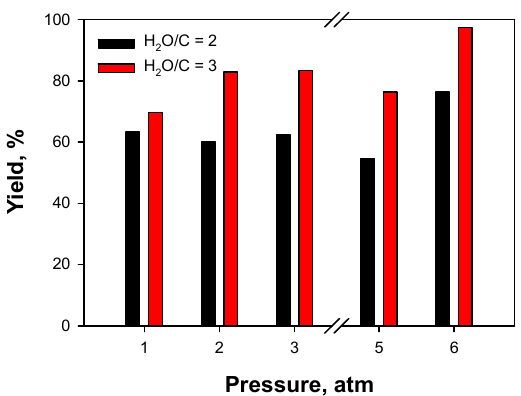
Figure 12. ( a ) H 2 /CO ratio as a function of pressure during steam reforming of AZ mixture on 5 Ni monolith at 720 °C; gas-phase feed composition: Solvent/H 2 O/O 2 /N 2 = 0.7/6/0/93.3; 0.7/6/0.8/92.5. ( b ) Coke yields as a function of the O 2 /C ratio.